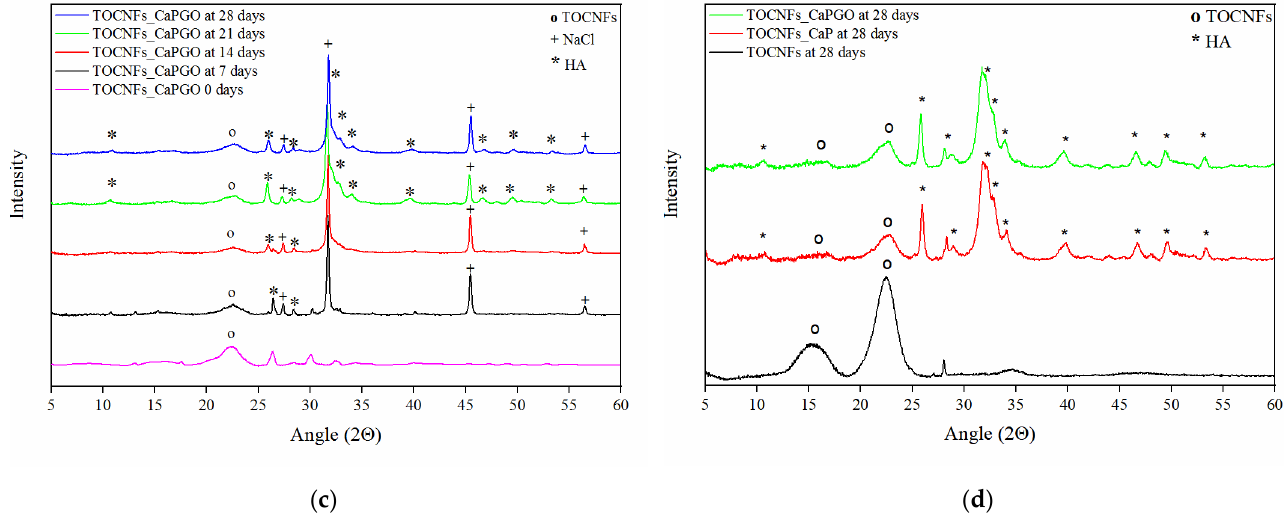
Figure 5. XRD diffraction patterns of nanocomposites hydrogels after 7, 14, 21 and 28 days of different specimens TOCNFs ( a ), TOCNFs CaP ( b ), TOCNFs CaPGO ( c ), and XRD of mineralized hydrogels at 28 days after water rinsing ( d ).